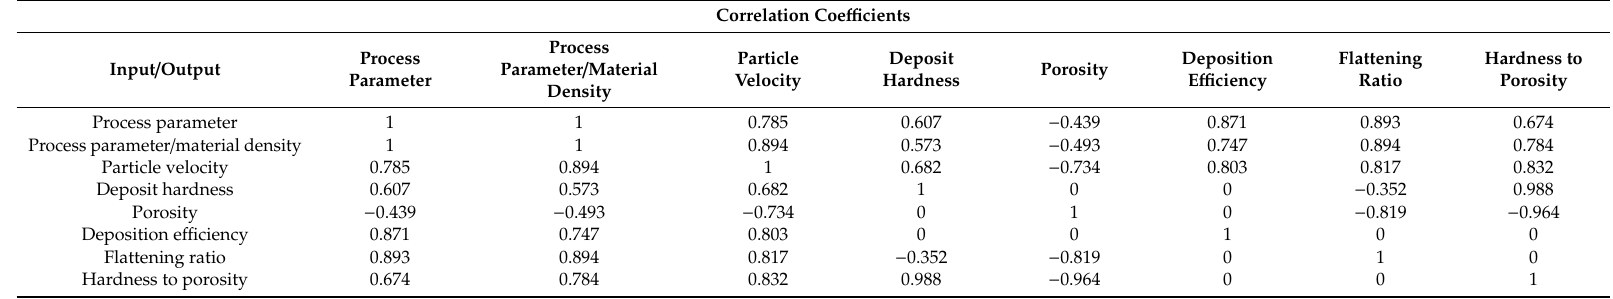
Table 4. Correlation behavior among the di ff erent input / output (taking into account the defined process parameter) employed in the present